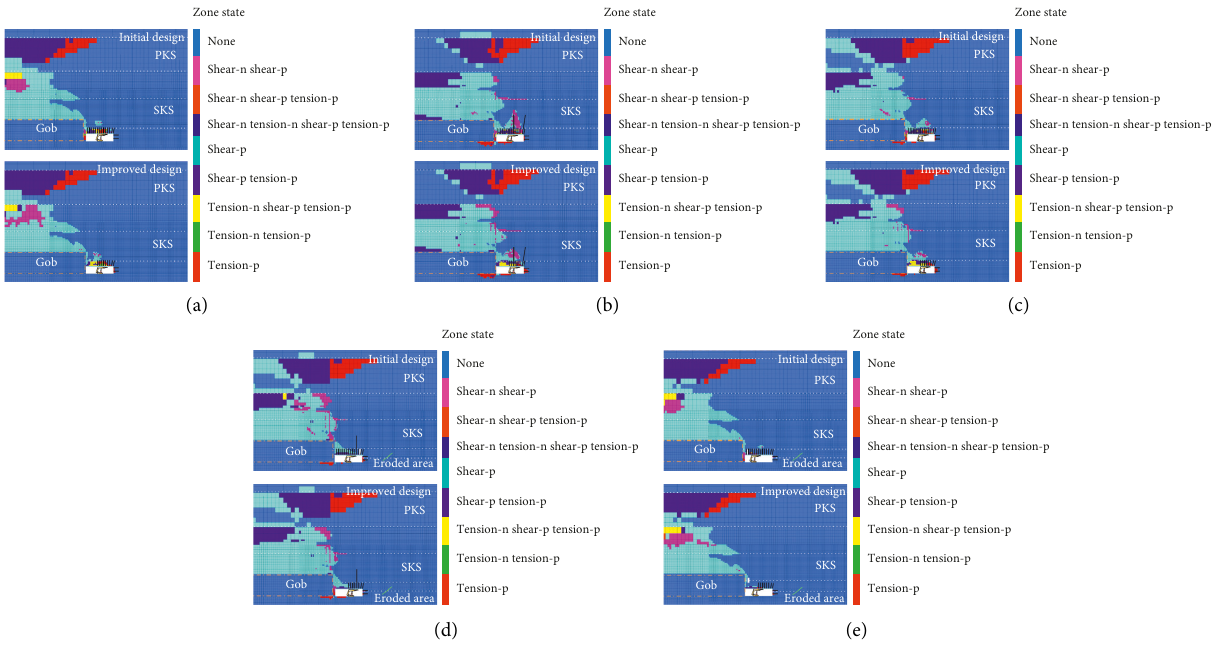
Figure 15: Plastic zone distribution of the two support parameter designs. (a) I-I. (b) II-II. (c) III-III. (d) IV-IV. (e)